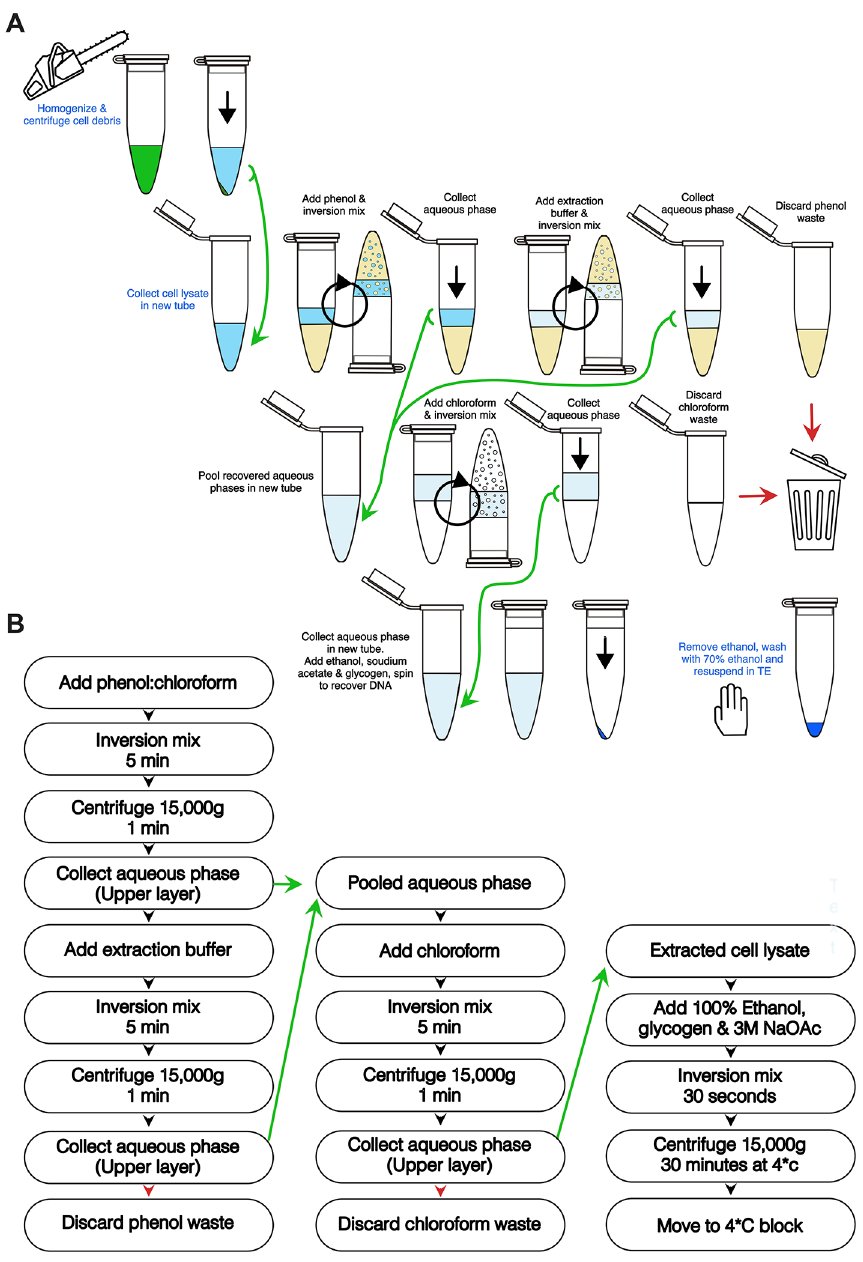
Figure2.GraphicaldescriptionoftheLabDroid ’ sworkflow. A,Schematicrepresentationofmanual(bluetext)and robotic (black text) manipulations. Circular black arrows indicate robotic “ hand-mixing ” inversions and black arrows, centrifugation.B,Automatedworkflowofextractionprotocol.Forbothpanels,greenarrowsindicatetransfertonew tube and red arrow heads, disposal of